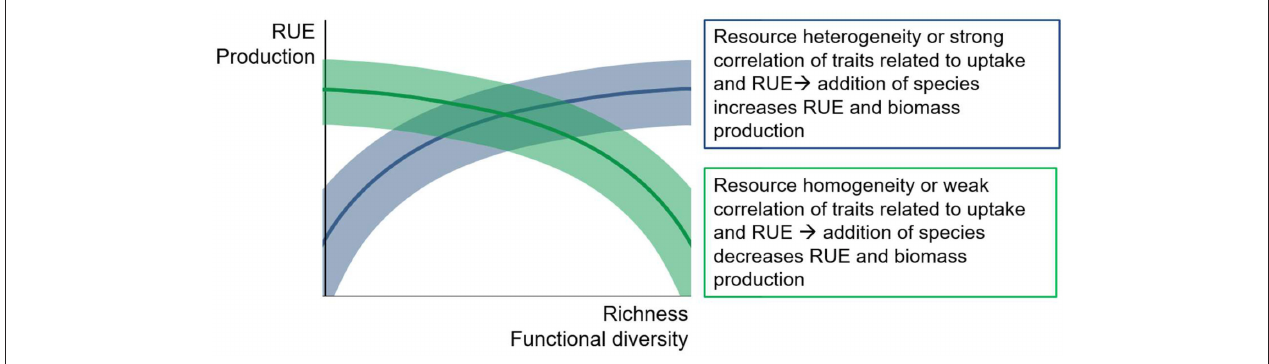
FIGURE 7 | Conceptual figure of possible relationships between diversity measures and resource use efficiency (RUE) or productivity. Positive, neutral or negative correlations are possible, depending on the match between resource supply and species assemblage. Shaded areas indicate potential variation around the general